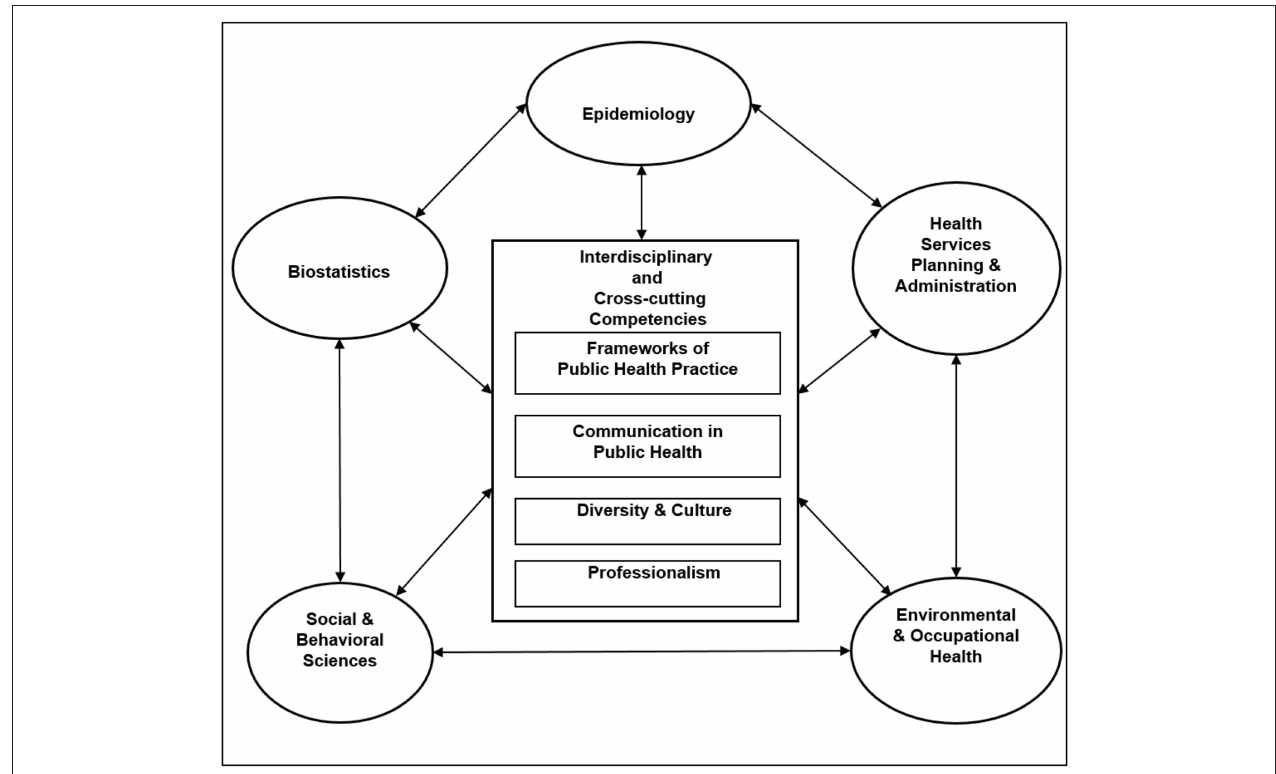
FIGURE 1 | Model of the BSPH program interdisciplinary and cross-cutting